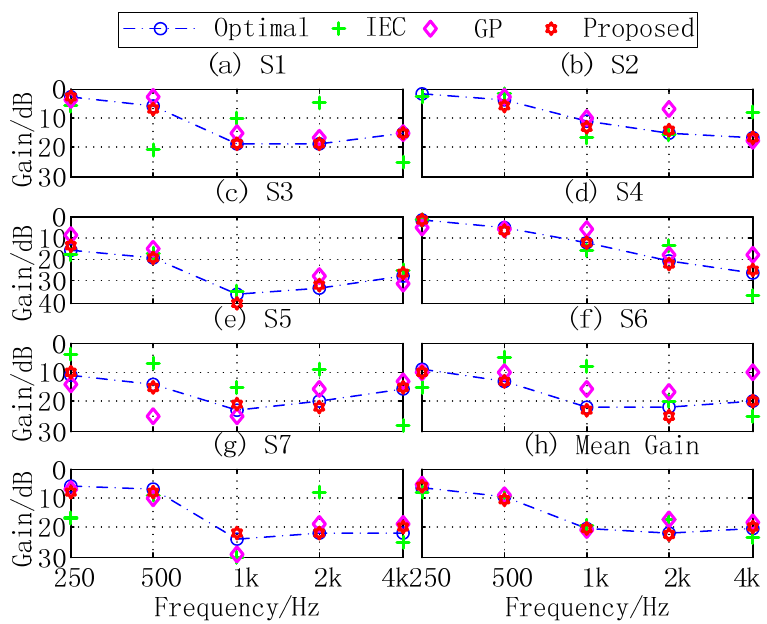
Figure 10. Gain estimation with seven subjects. ( a ) S1; ( b ) S2; ( c ) S3; ( d ) S4; ( e ) S5; ( f ) S6; ( g ) S7; ( h ) Mean Gain.